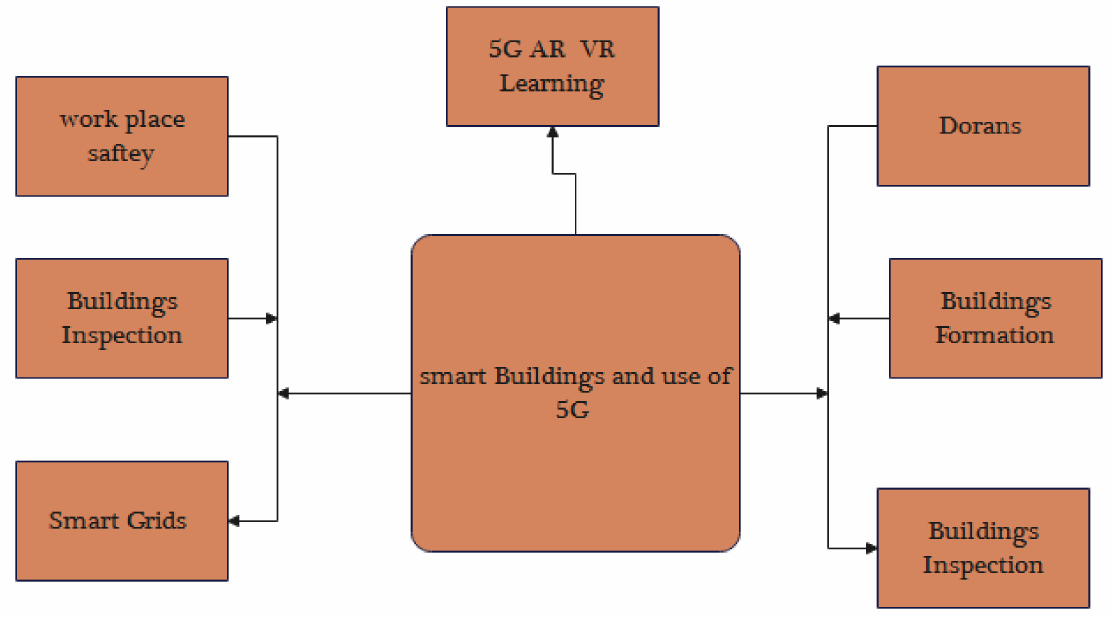
Figure 8. Industry 4.0 framework for digital education technologies